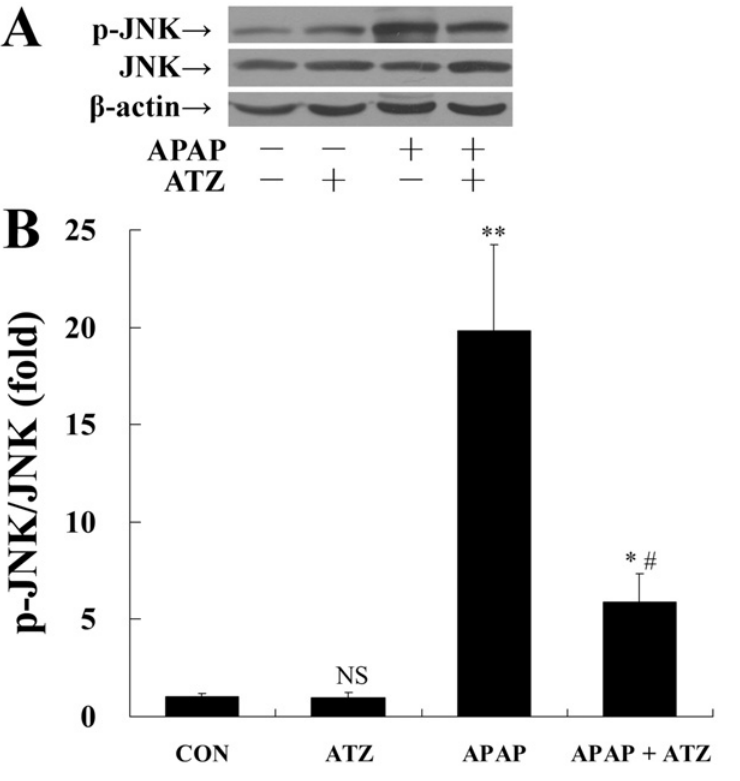
Fig 6. Pretreatment with ATZ decreased the level of phosphorylated JNK in APAP exposed mice. Mice were treated with vehicle or ATZ (500 mg/kg) at 30 min before APAP exposure. Liver samples were harvested at 8 h after APAP exposure. The levels of phosphorylated JNK and total JNK were determined by Western blot analysis. (A) The bands of phosphorylated JNK, total JNK and β -actin were indicated by arrows. (B) Western blots were scanned by densitometry and data presented as relative intensity units. Data were expressed as mean ± SD, n = 8. NS P > 0.05, * P < 0.05, ** P < 0.01, as compared with the CON group; # P < 0.05, as compared with APAP